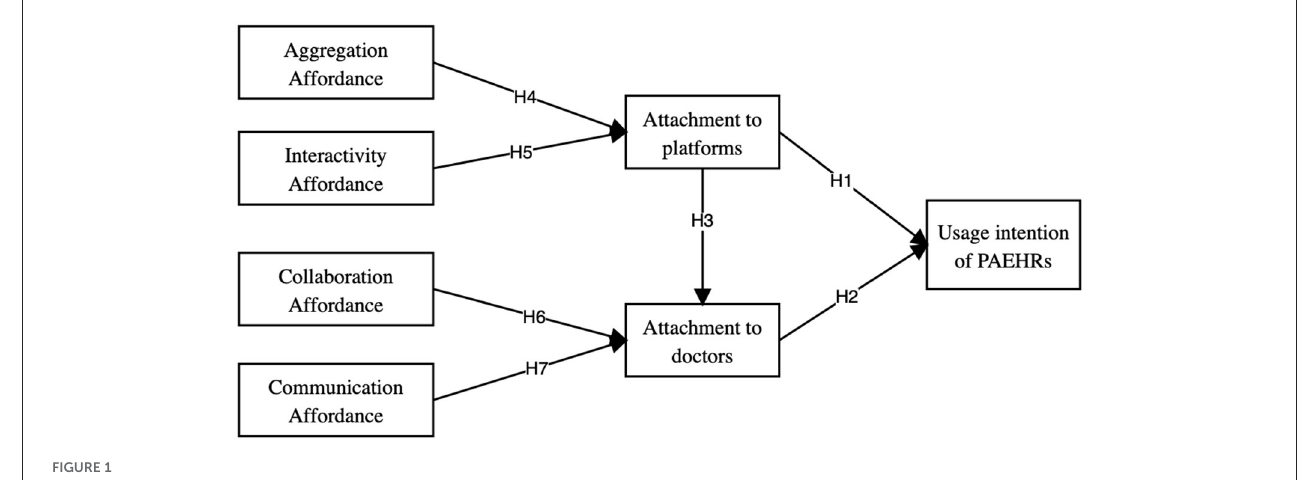
FIGURE1 Research